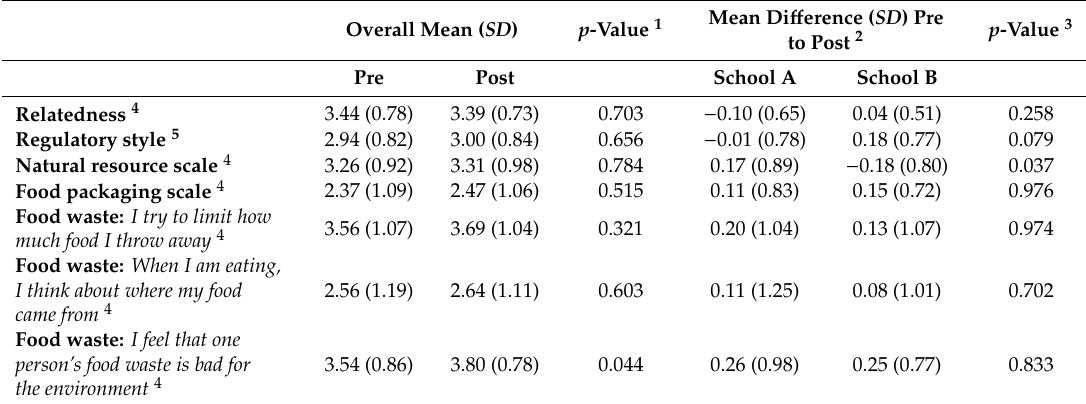
Table 4. Comparison of changes in classroom survey measures pre to post.